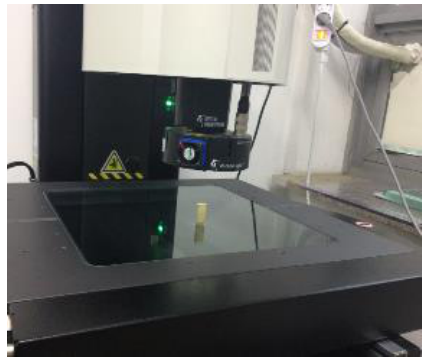
Figure 12. Measurement of manufactured magnet. Table 5. Measured